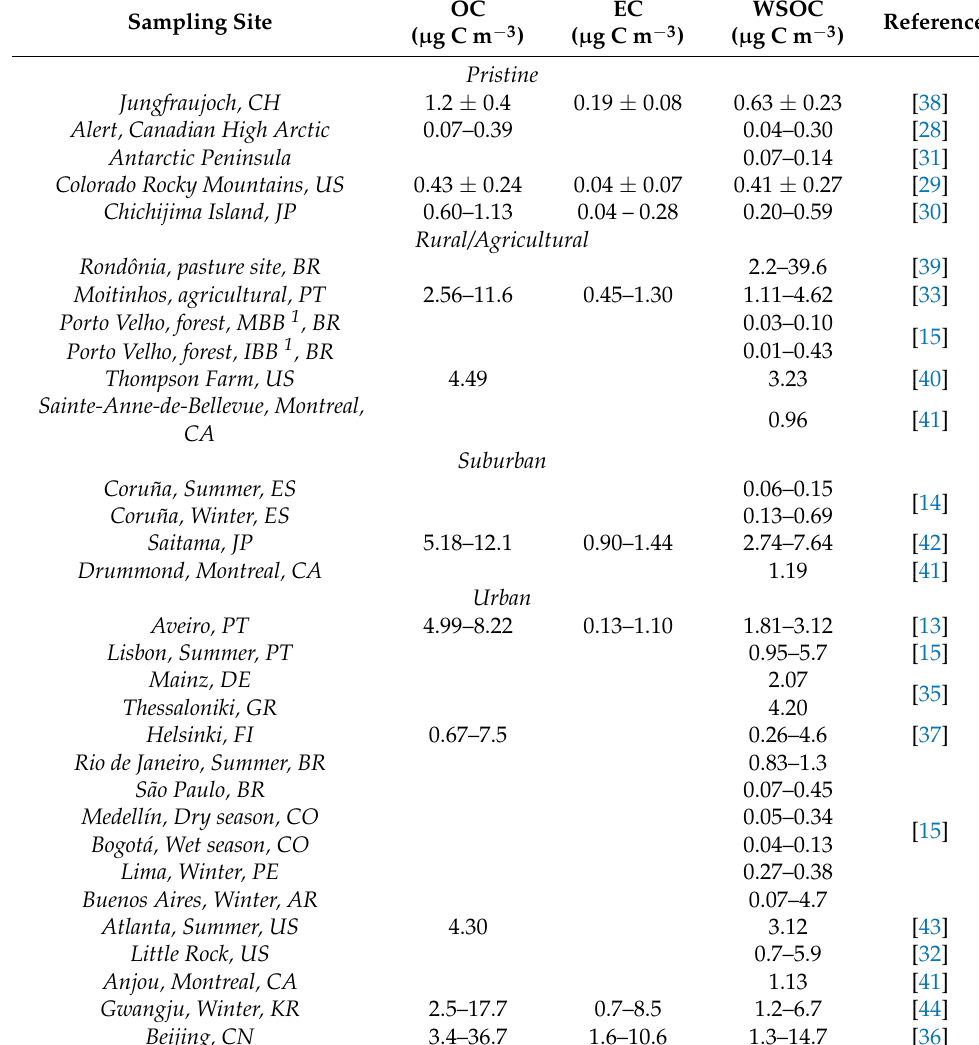
Table 1. A few examples of ambient concentrations (either range or average values) of OC, EC, and WSOC in areas with different levels of